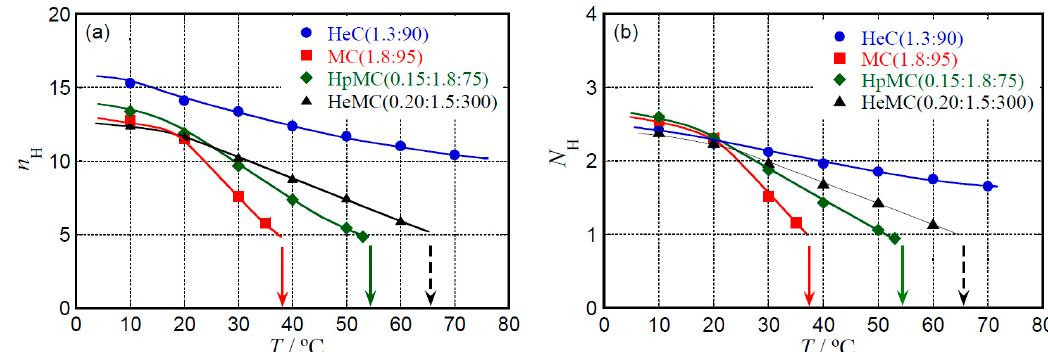
Figure 7. ( a ) T dependence of the n H values for HeC(1.3:90), MC(1.8:95), HpMC(0.15:1.8:75), and HeMC(0.20:1.5:300). Solid arrows in this figure represent the lowest cloud point observed in a high concentration side, i.e., lower critical solution temperature (LCST). A dotted arrow represents a gelation point without turning into the turbid state for aqueous solution of HeMC(0.20:1.5:300) at 0.1 M. ( b ) T dependence of the N H values for each chemically modified cellulose sample.